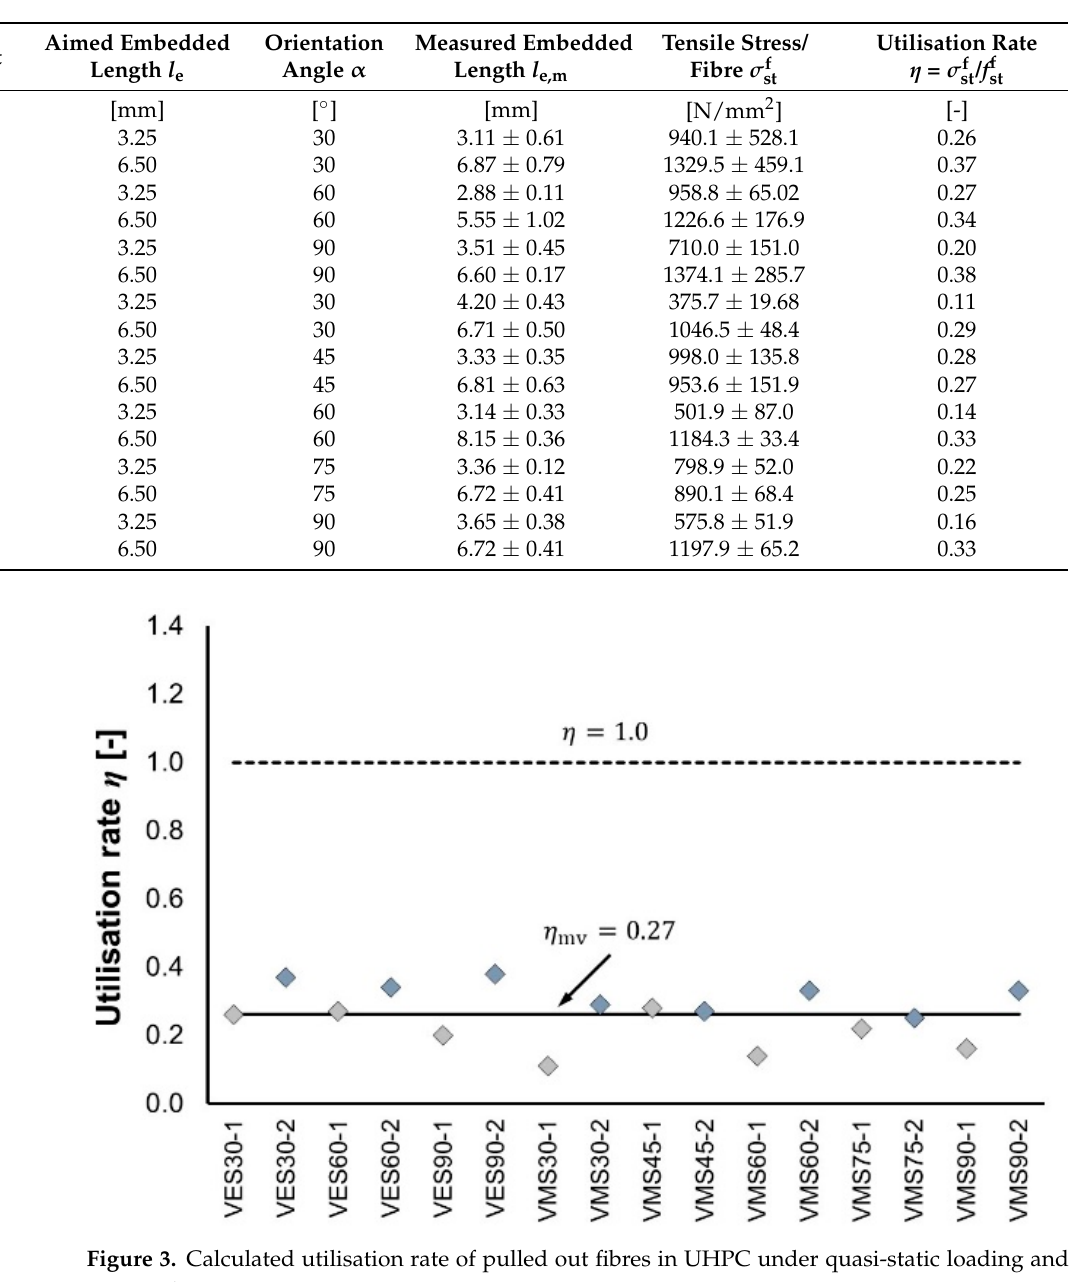
Table 2. Test results, calculated tensile stresses and utilisation rate in relation to the fibre strength.